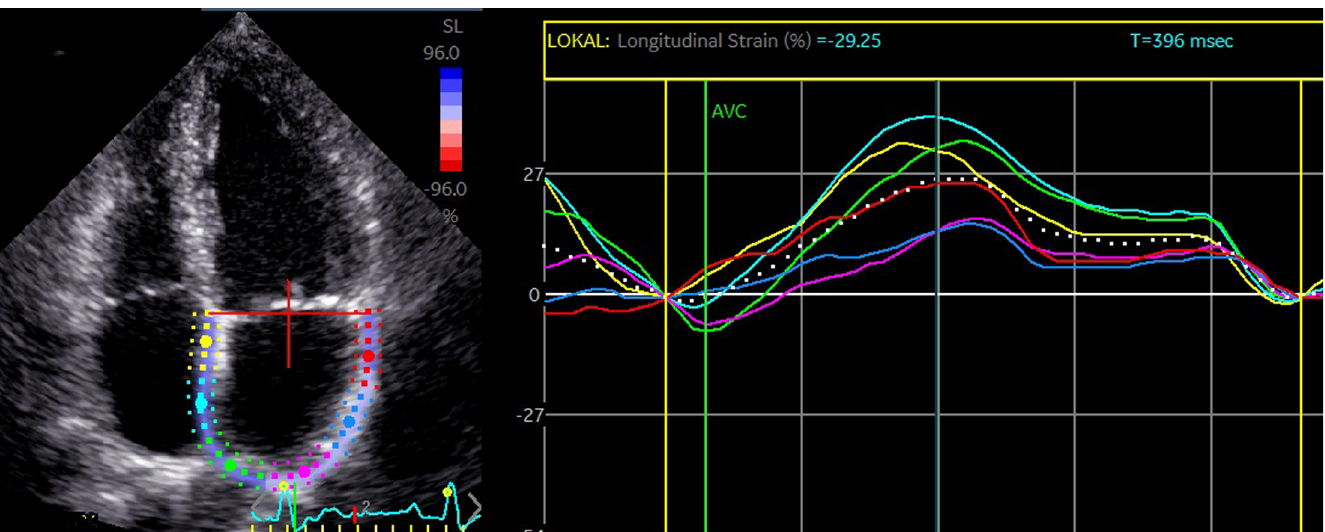
PLOS ONE | https://doi.org/10.1371/journal.pone.0266951 April 12,